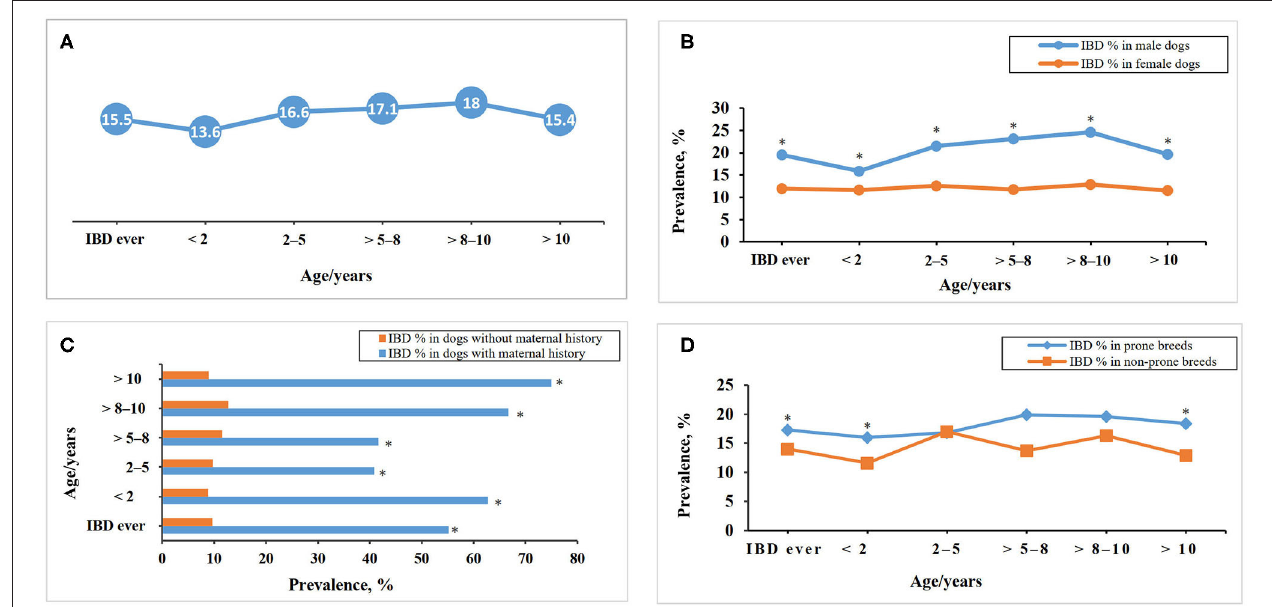
FIGURE 3 | Inflammatory bowel disease prevalence within different age groups in the DogRisk food frequency questionnaire population, n = 10468, (A) and when the population was stratified for gender (B) , maternal history (C) , and disease predisposition in the different breeds (D) . *The difference between the two groups within each age group is significant at P <